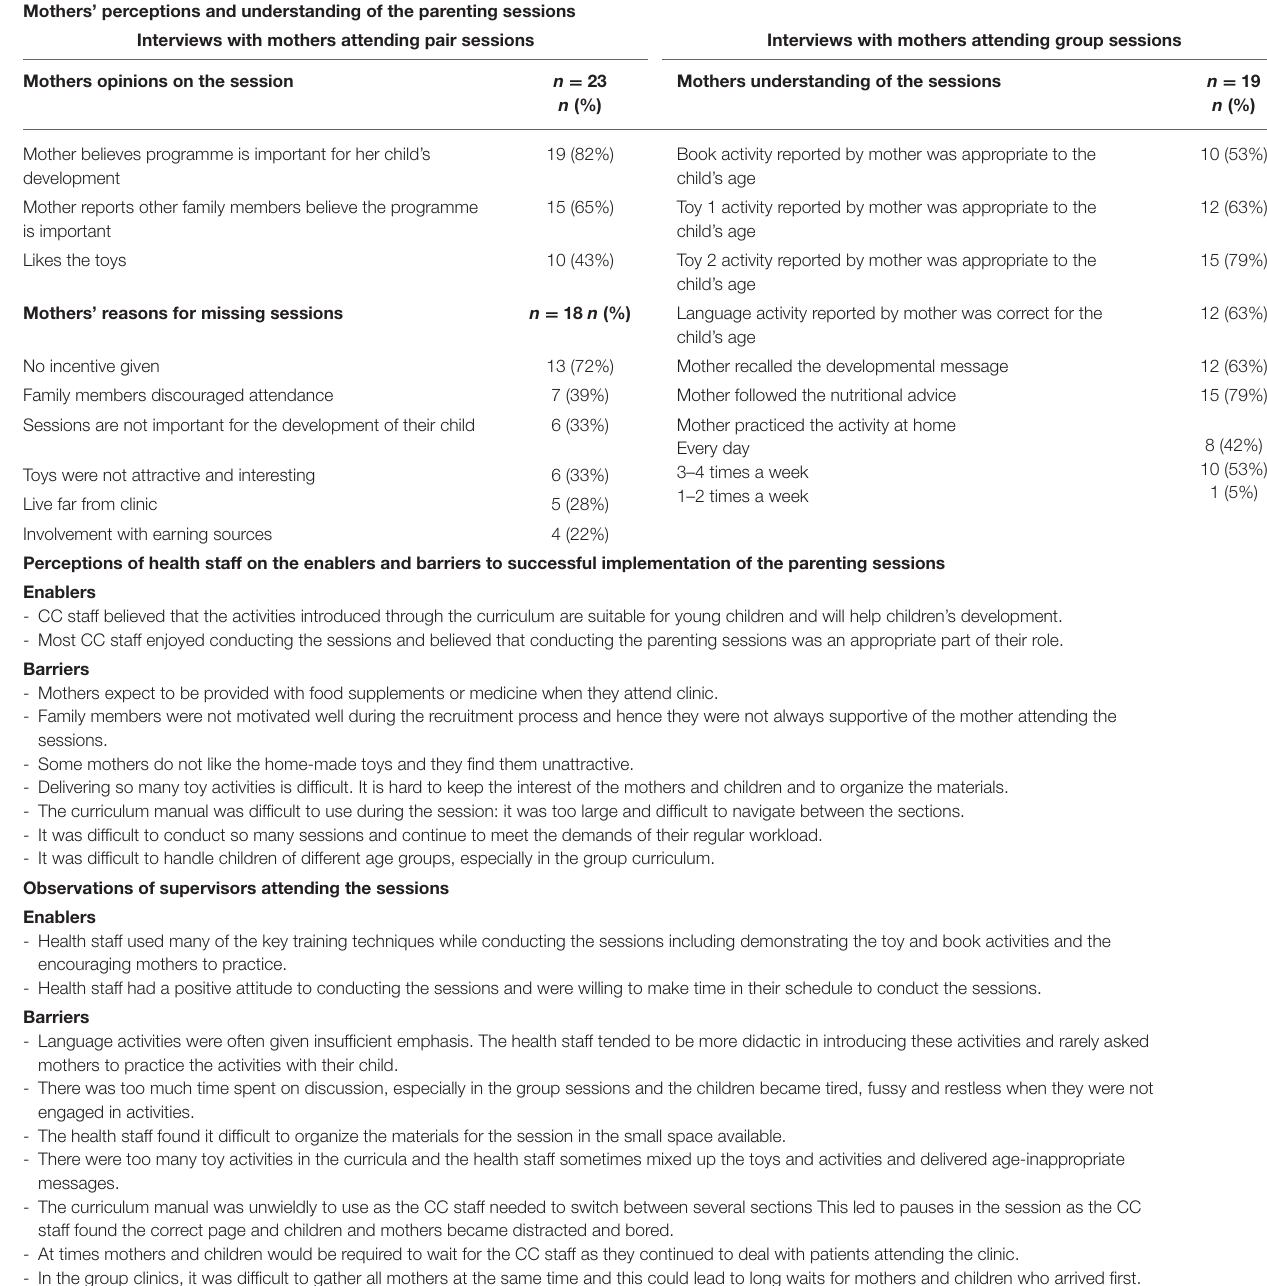
TABLE 3 | Supervisors’, health staff and mothers’ perceptions in stage